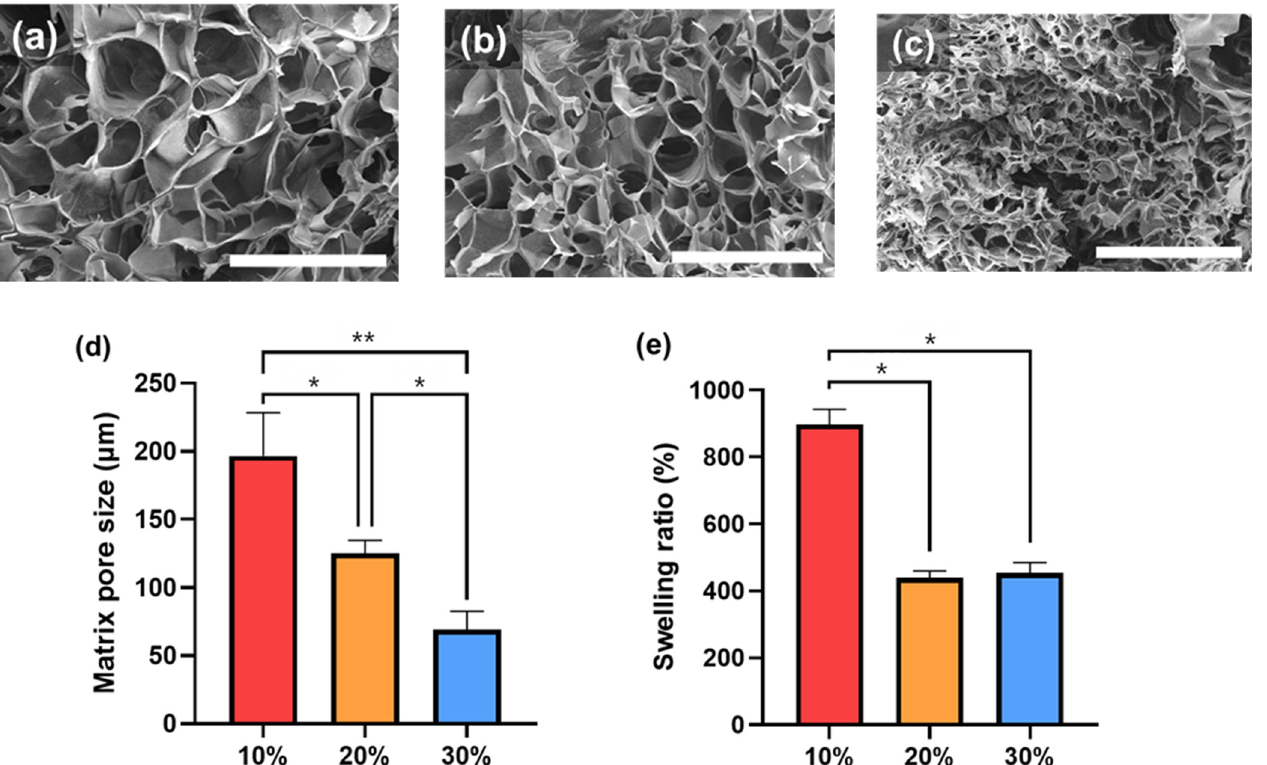
Figure 3. Scanning electron microscopy (SEM) images of ( a ) 10%, ( b ) 20%, and ( c ) 30% furfuryl- gelatin hydrogels. Scale bars are 500 µ m. ( d ) Matrix pore sizes of furfuryl-gelatin hydrogel matrices (n = 10). ( e ) Equilibrium swelling ratio of furfuryl-gelatin hydrogels. The significant differences are represented by 0.01 < p < 0.05 (*) and p < 0.01 (**).